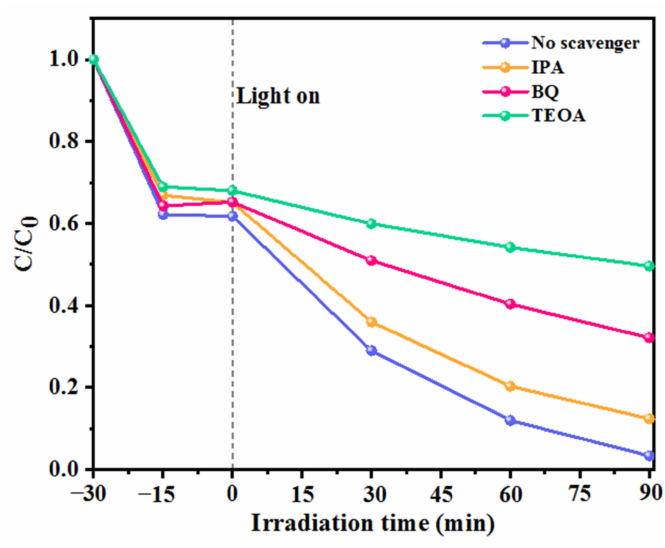
Figure 11. Effects of radical scavengers on the degradation of MB for CNAC-10